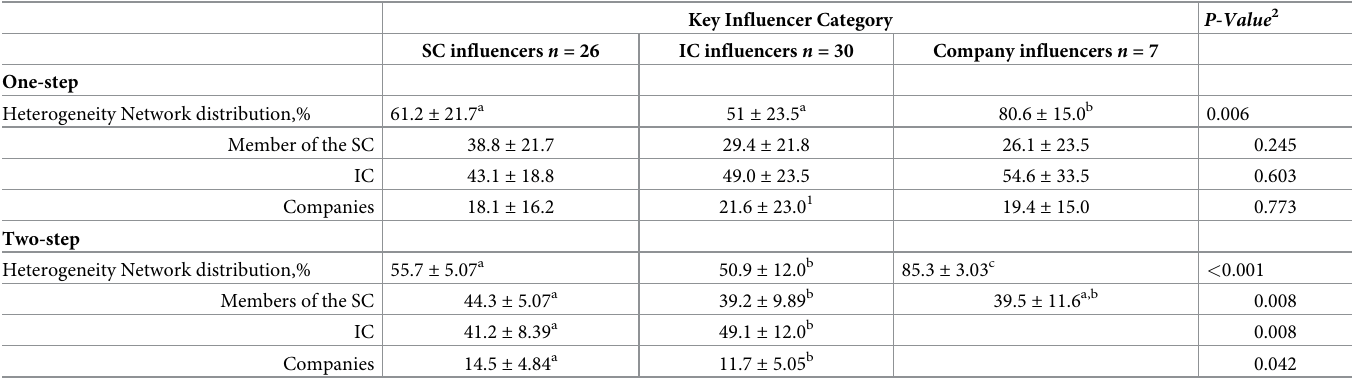
Table 2. Differences in heterogeneity and network distribution by category.